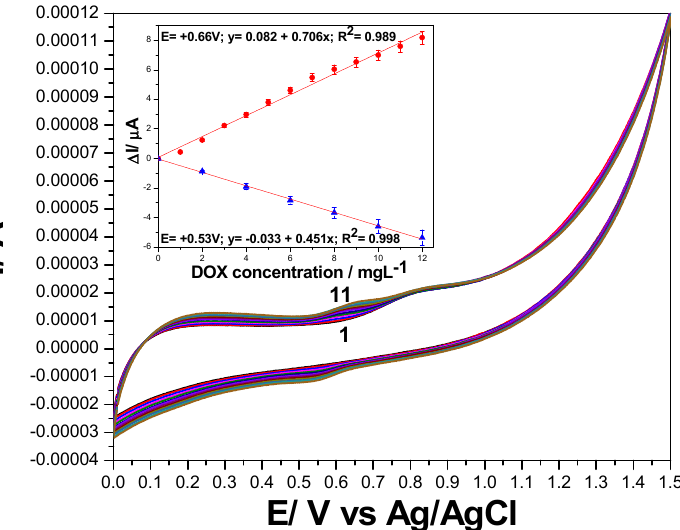
Figure 4. Cyclic voltammograms recorded at GRQD/CNT paste electrode in 0.1 M Na 2 SO 4 supporting electrolyte (curve 1) and in the presence of various DOX concentrations: 1–10 mg · L − 1 (curves 2–11), potential scan rate: 0.050 V · s − 1 ; potential range: 0.00 to +1.50 V vs. Ag/AgCl. Inset: Calibration plots of current recorded at +0.250 V vs. Ag/AgCl, and +0.660 V vs. Ag/AgCl on anodic branch, and +0.530 V/Ag/AgCl vs. DOX concentration on cathodic branch.